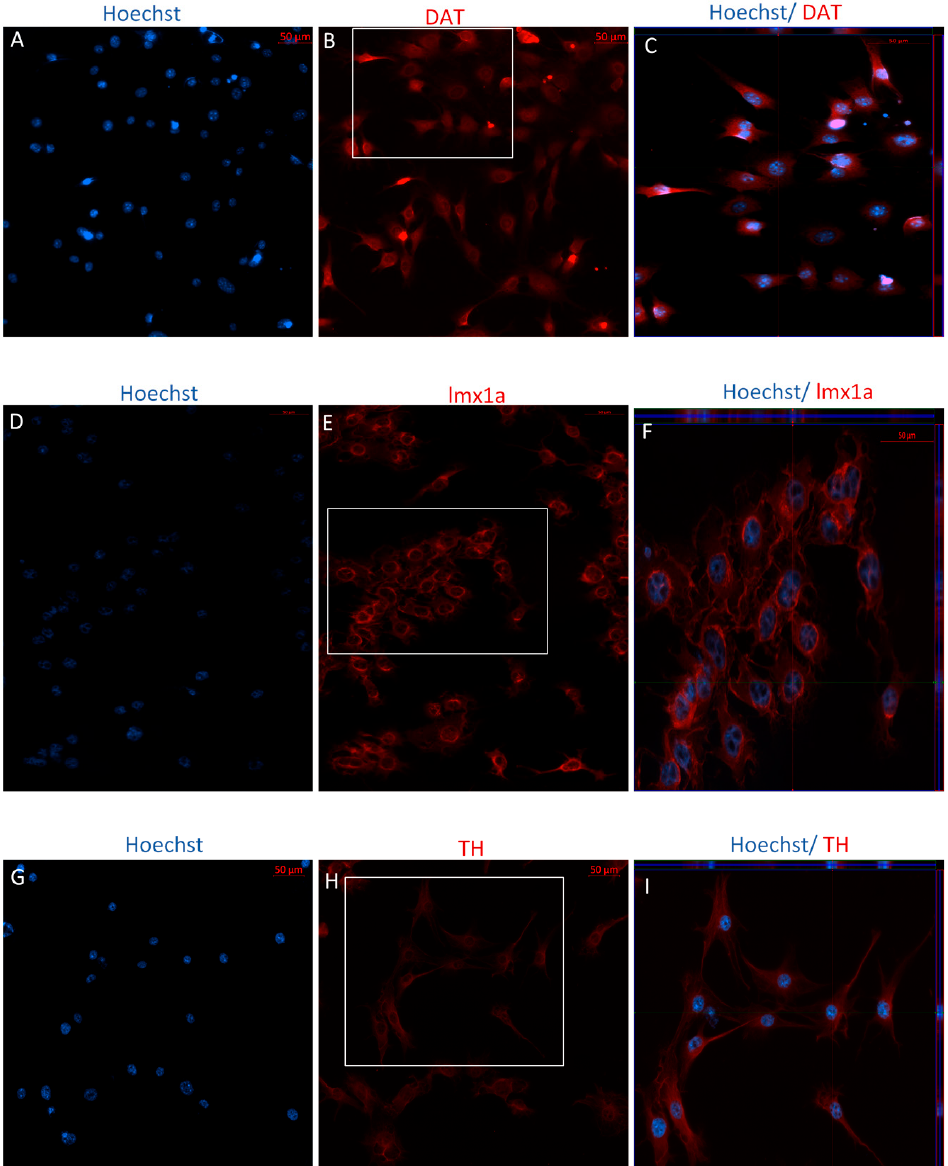
Figure 5. Immunocytochemistry/immunofluorescence (ICC/IF) performed on P40 MSCs following the DDI. Hoechst-labeled P40 MSCs ( A , D , G ) revealed positive staining of the mature dopaminergic markers DAT (( B ) red) and TH (( H ) red), and the immature dopaminergic marker LMX1a (( E ) red), following exposure to SHH, FGF-8, bFGF, and BDNF. Orthogonal displays of z -stacks are represented in merged images ( C , F , I ). Table 2. Flow Cytometry analysis following the DDI and